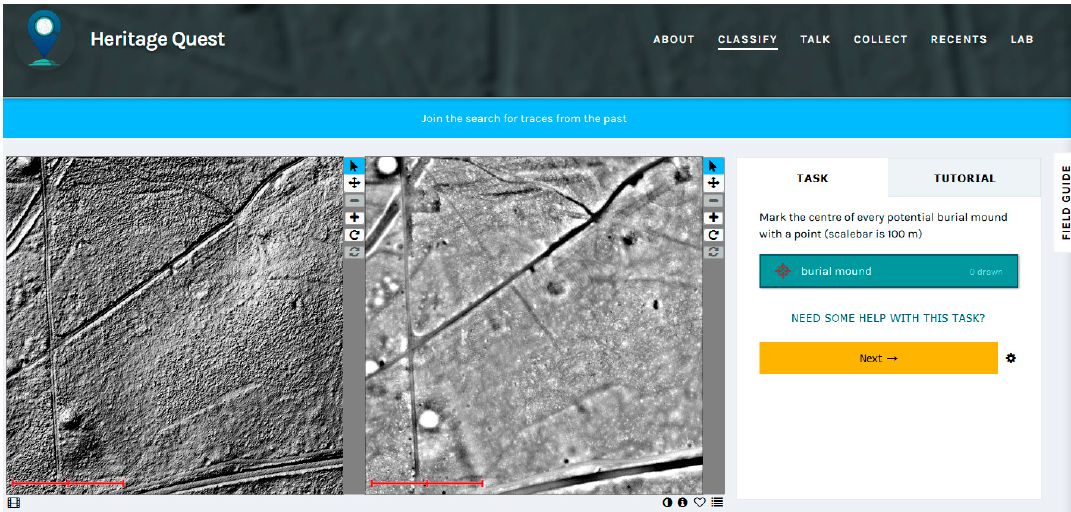
Figure 7. Classifying archaeological objects in LiDAR images in the Heritage Quest project [100].